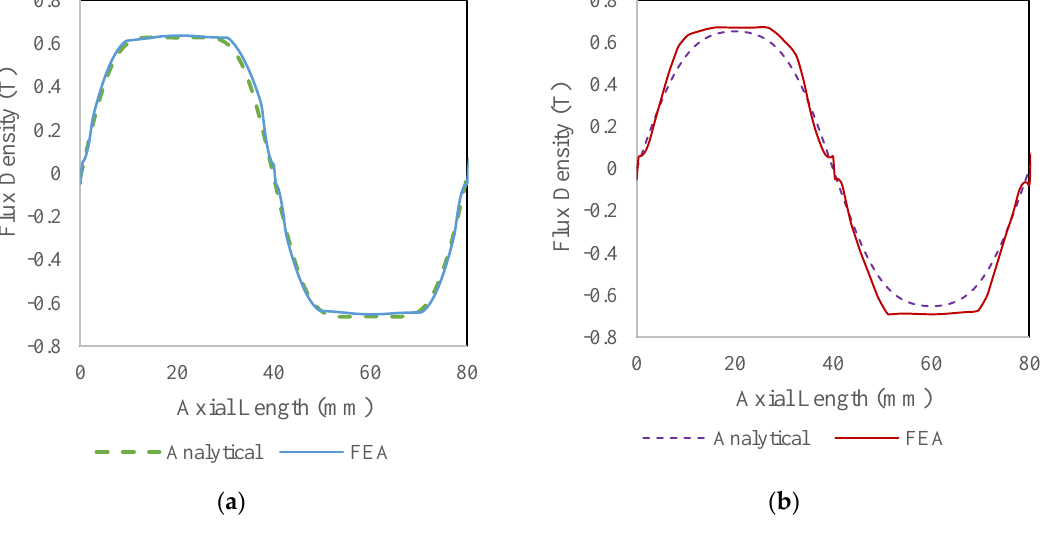
Figure 25. Airgap Flux Density Validation of ( a ) TPMLM-NS; ( b ) TPMLM-S.